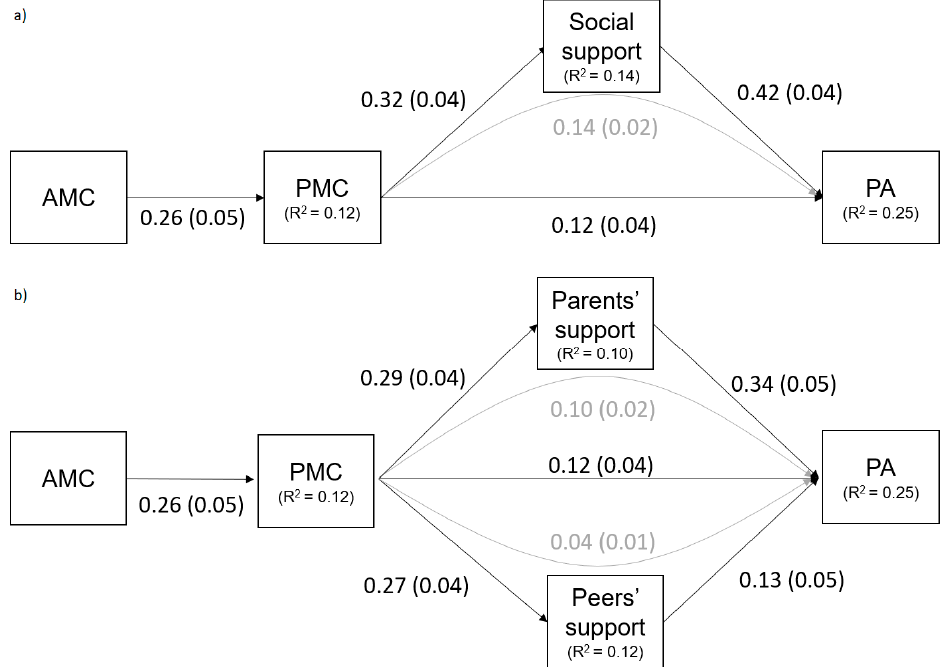
Figure 1. Path models for relations between actual motor competence (AMC), perceived motor competence (PMC), perceived Social Support, and physical activity (PA) ( a ), and between AMC, PMC, Parents’ and Peers’ Support, and PA ( b ). Models were represented with standardized coef- ficients (ß), standard errors (SE), and R-squares. (Note. Black and grey values refer to direct and indirect relationships, respectively. Solid arrows indicate significant relationships. Non-significant relationships were not found. Measured variables are represented with squares.).